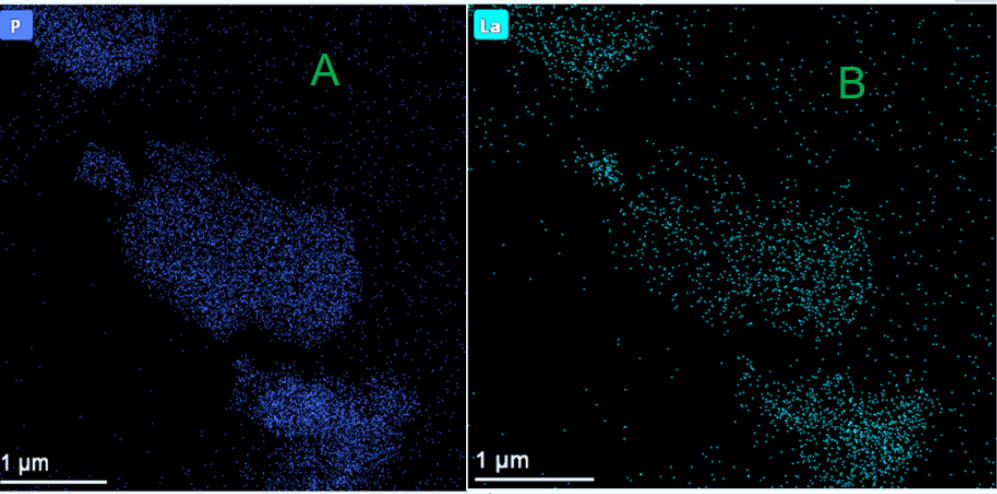
Figure 14. Phosphorus spot map ( A ) and lanthanum spot map ( B ) after adsorption of fly ash pellets.